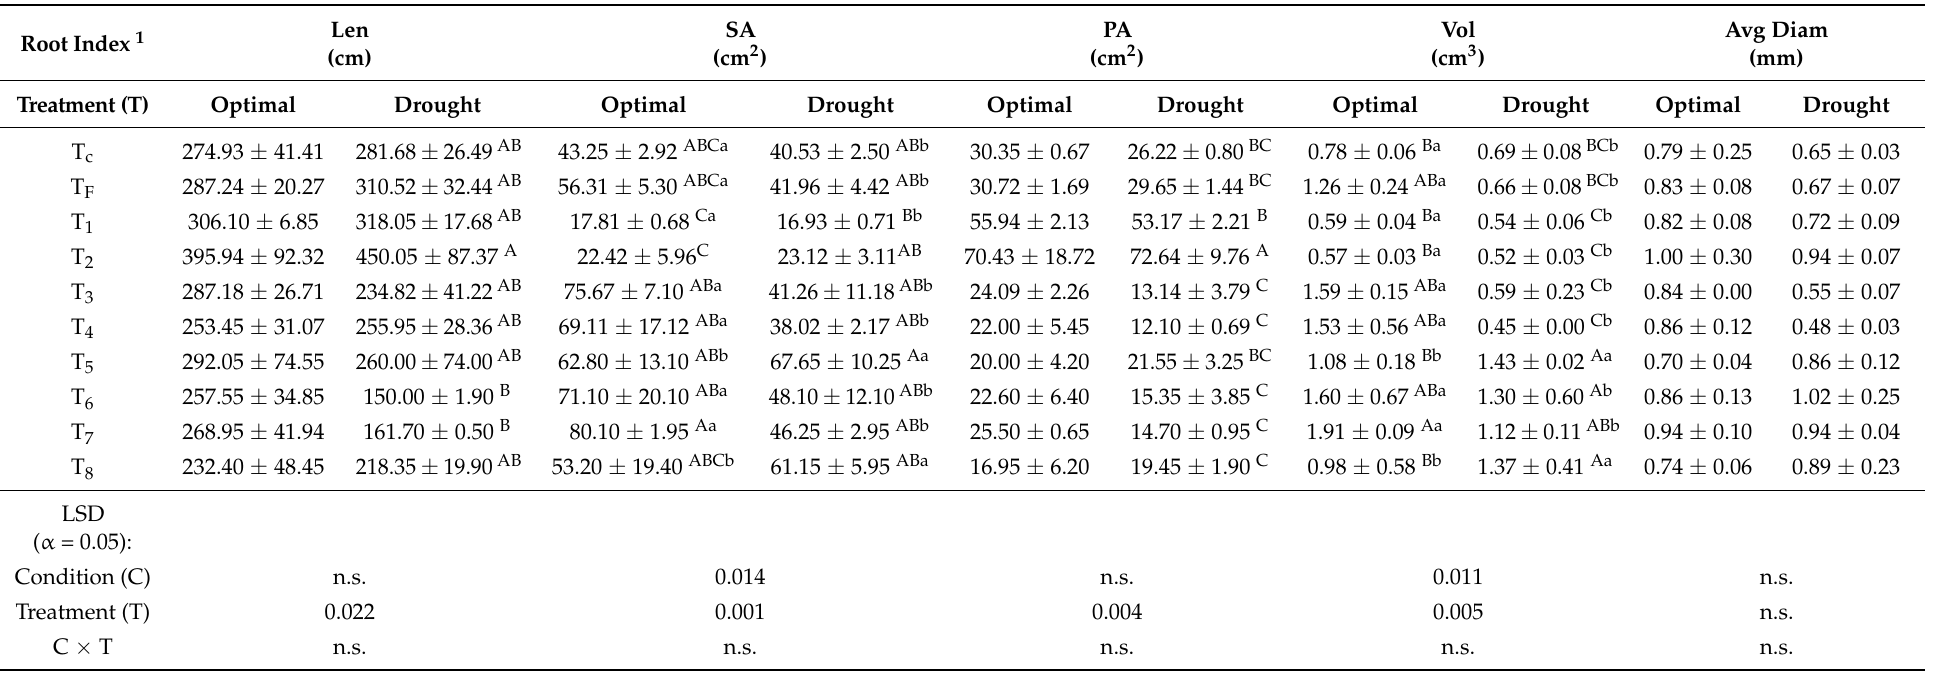
Table 4. Effects of drought stress and fertilizer treatment on root index for